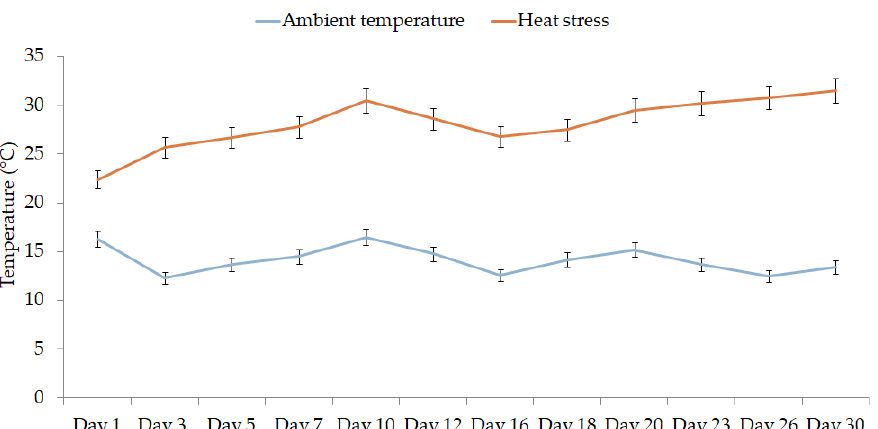
Figure 7. Average of the growth chambers recordings during the experiment .